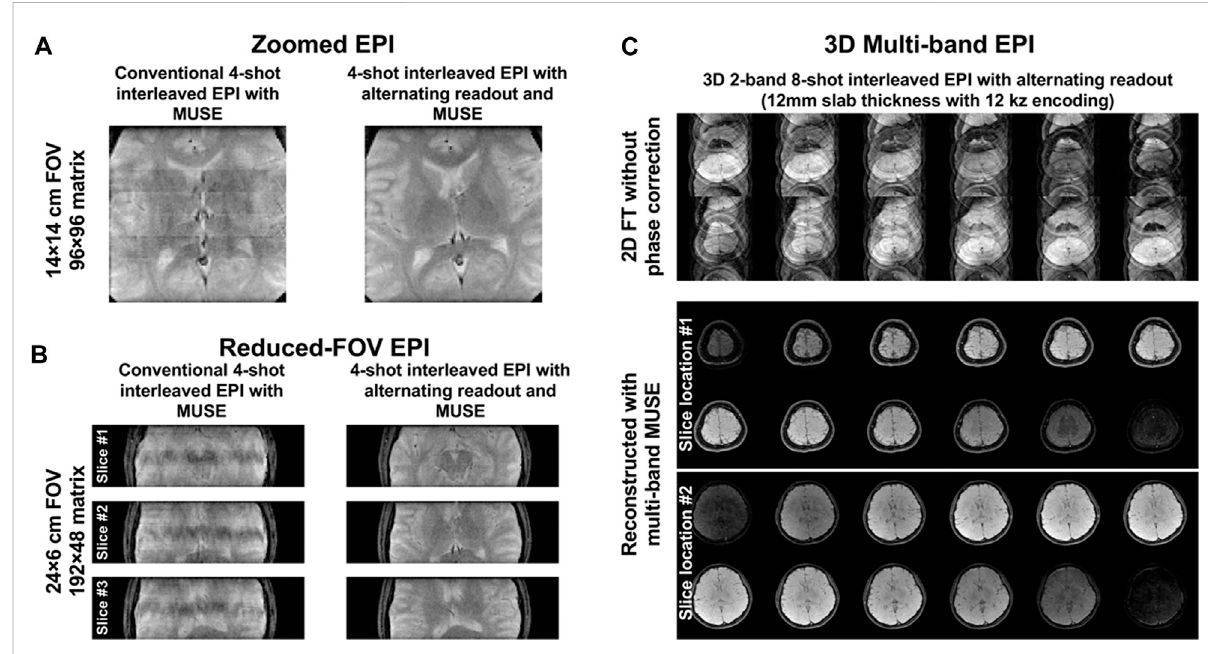
FIGURE 7 (A) Zoomed EPI and (B) reduced-FOV EPI images produced from MUSE reconstruction of the data acquired using either conventional 4-shot interleaved EPI or 4-shot interleaved EPI with alternating readout. The proposed method with alternating readout can successfully perform 2D Nyquist ghost correction for the data acquired with very tight FOV. (C) 3D multi-band EPI dataset acquired using 3D 2-band 8-shot interleaved EPI with alternating readout and reconstructed with multi-band MUSE framework. The encoded slices from two different excited slab locations were successfully separated with simultaneous 2D Nyquist ghost correction. It demonstrated that the proposed method can also be extended to deal with the Nyquist ghost artifacts present in 3D multi-band multi-shot EPI, proving its potential in